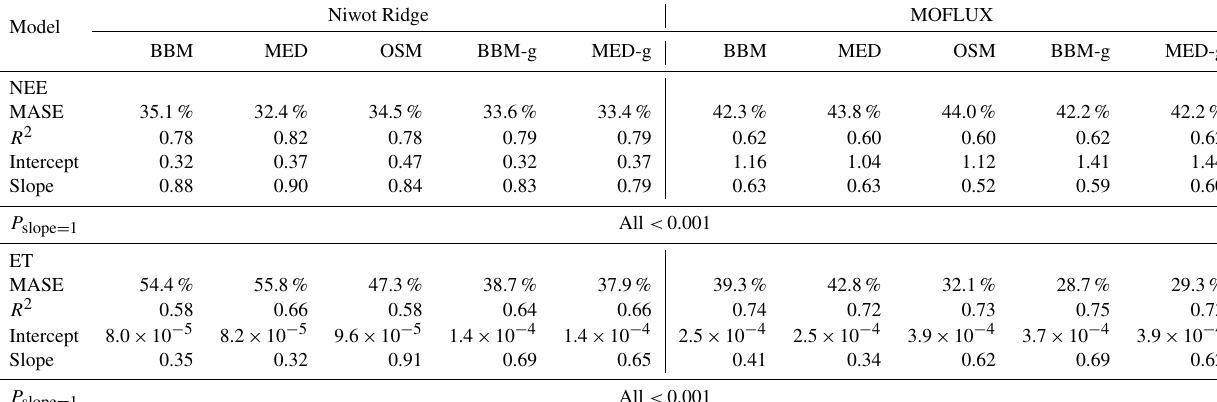
Table 4. Statistics of the three stomatal models’ predictive skills. The models are the Ball et al. (1987) model (BBM), the Medlyn et al. (2011) model (MED), and the Wang et al. (2020) model (OSM). The NEE section shows the regression details of the modeled vs. observed net ecosystem carbon flux (NEE), whereas the ET section shows the regression details of the modeled vs. observed ecosystem water flux (ET). The MASE row shows the mean absolute standardized error (mean for each year). The P slope = 1 row indicates the P value for which the slope is not different from one. The BBM-g and MED-g columns display the results when an extra empirical parameter “ g 1 ” (Eqs. 6, 7) is also fitted for the empirical